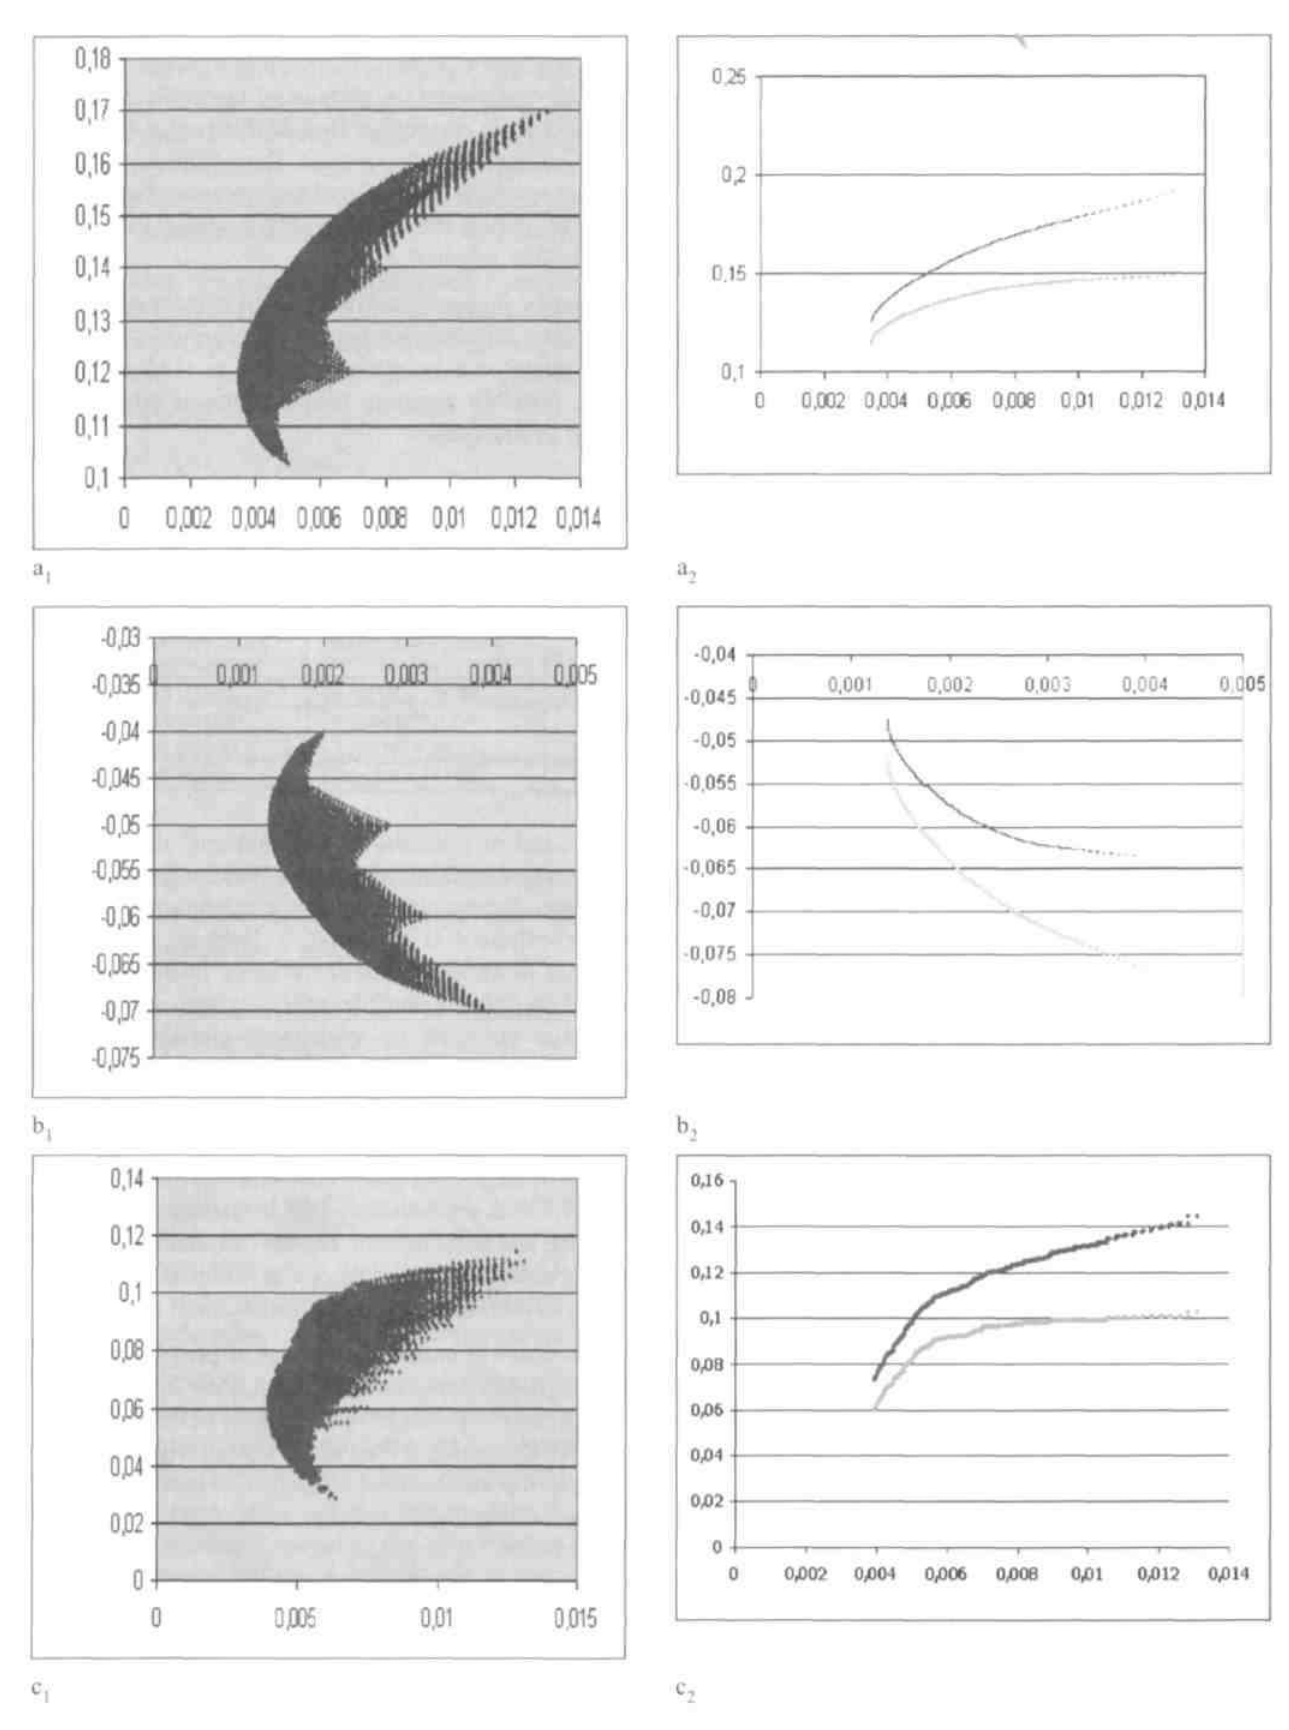
Fig 4. The main characteristics of a bank integrated assets and liabilities portfolio: a, an assets portfolio; b, a liabilities portfolio; c, assets and liabilities integrated portfolio; a